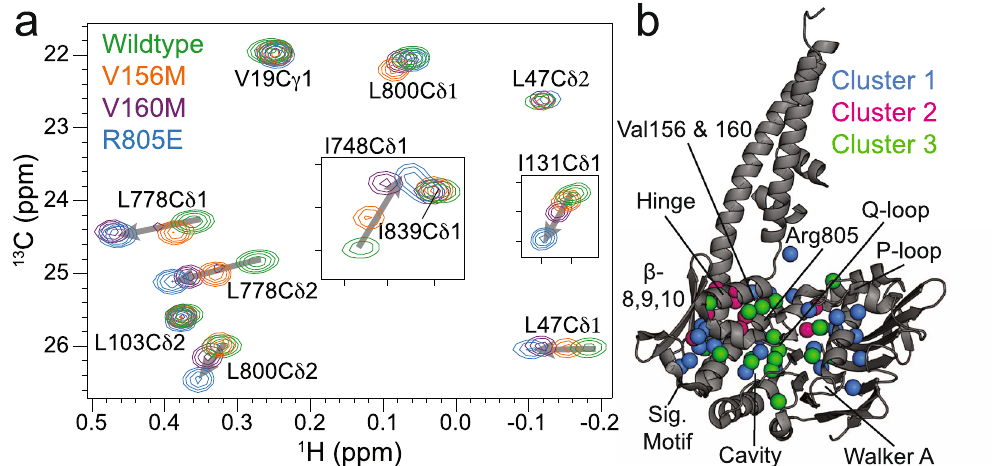
Figure 2. Mutations reveal an allosteric network in Rad50 NBD . ( a ) 2D 13 C, 1 H methyl-TROSY HMQC spectral overlay of WT and mutant Mre11 HLH -Rad50 NBD recorded at 14.1 T and 50 °C. Arrows highlight side chain methyl groups experiencing CSPs. ( b ) Structure of Mre11 HLH -Rad50 NBD emphasizing side chain methyl groups whose CSPs upon mutation cluster according to CHESCA as described in the Methods. Clusters are listed in Supplementary Table S1 and were determined via the dendrogram in Supplementary Fig. S4. Methyl groups not affected by the mutations are not